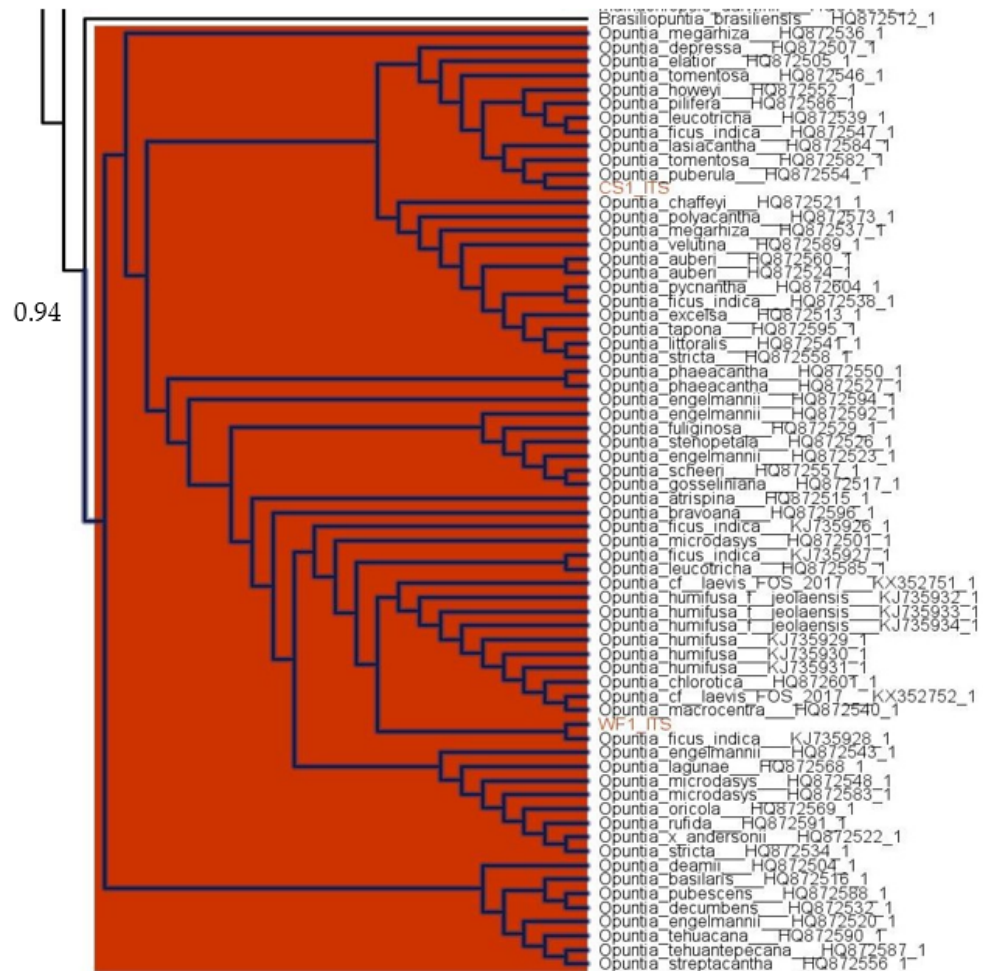
Figure 2. PHYML phylogenetic tree section of the ITS gene region, considering one of the Op- untia sp. branches (red) with a support value of 0.94 and both the comercial (CS1_ITS) and wild (WF1_ITS)